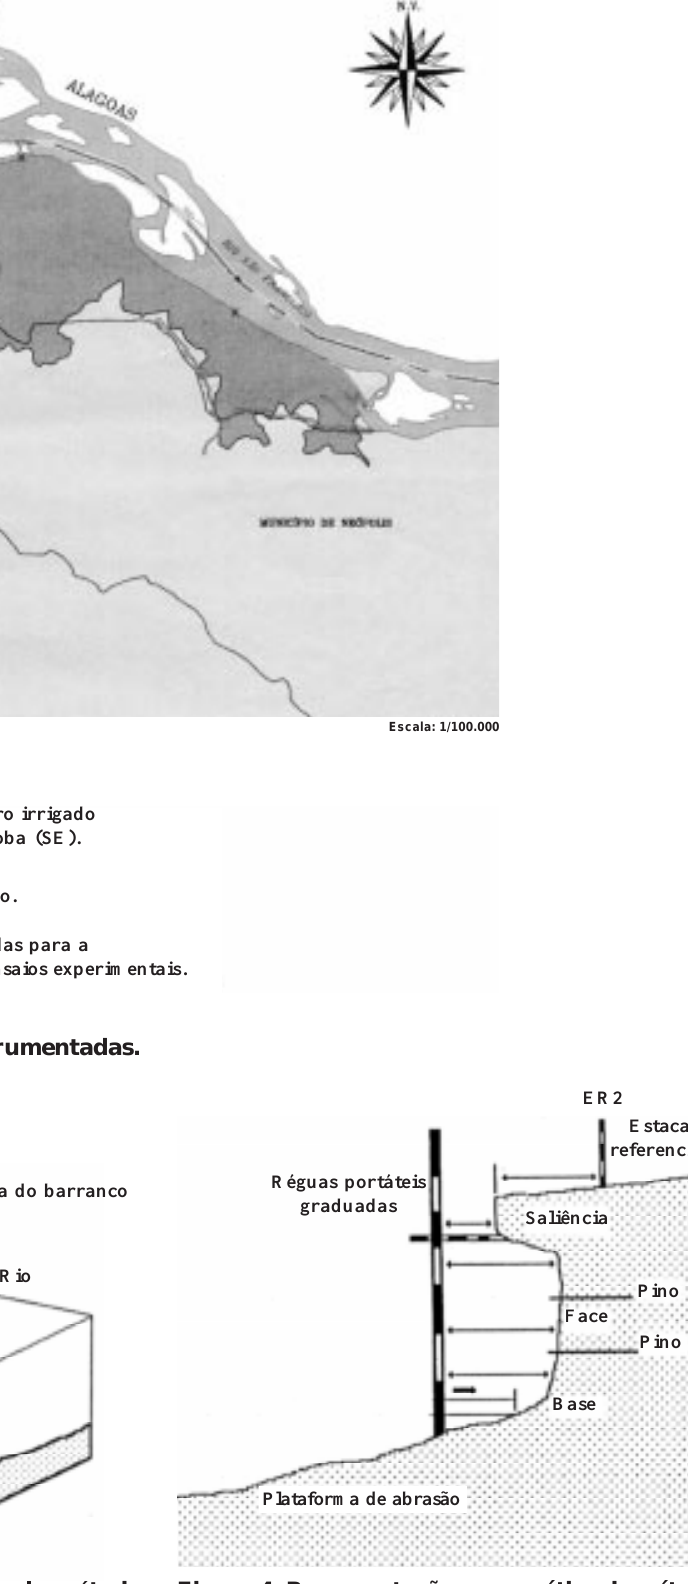
Figura 4. Representação esquemática do método das perfilagens sucessivas. (Fonte: Hudson, 1981, p.382,